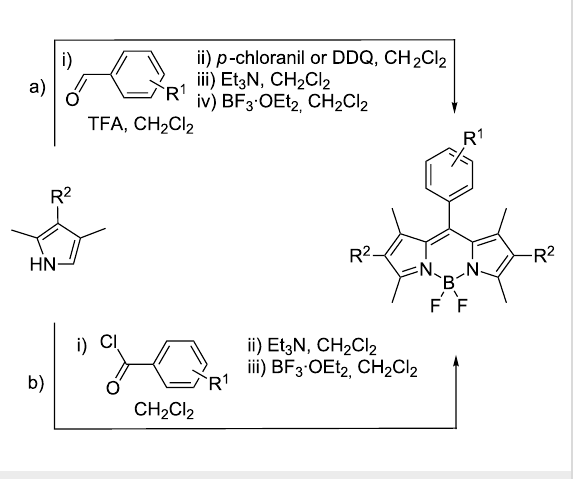
Scheme 1: Literature preparations of symmetric, meso -substituted BODIPY dyes.